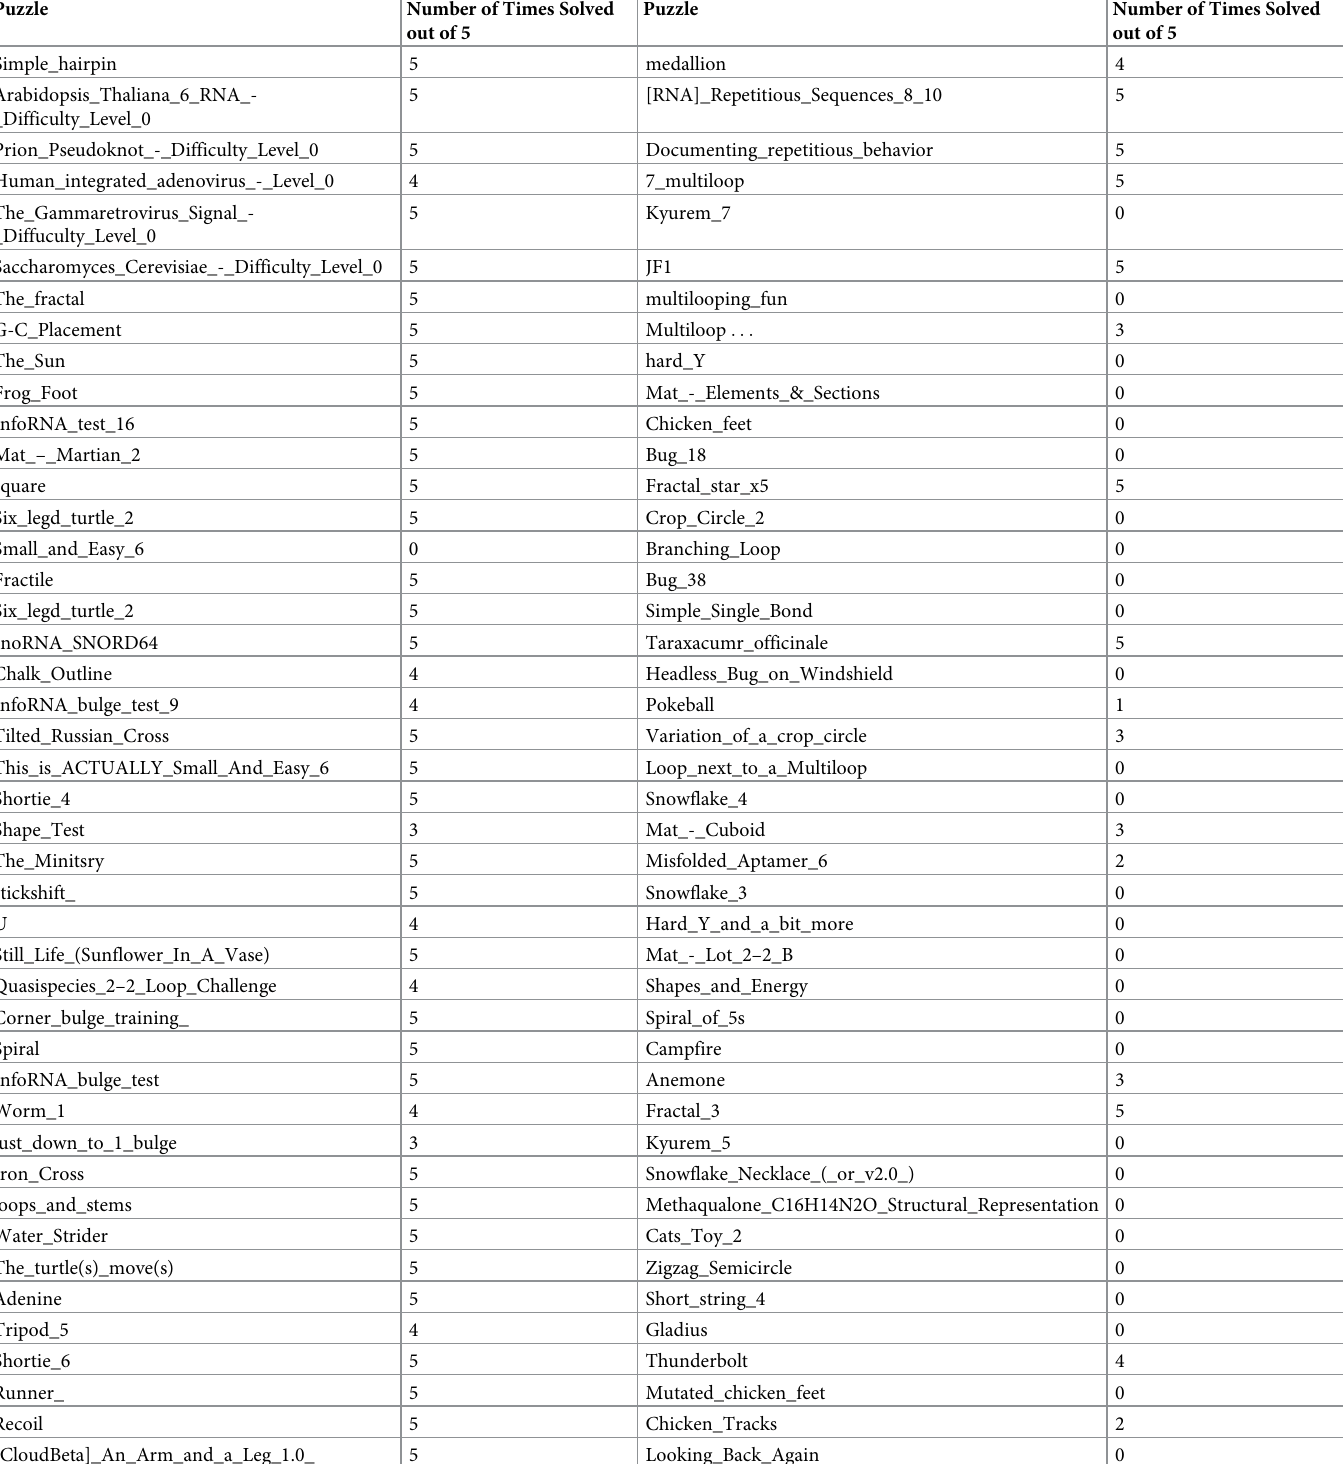
Table 4. EternaBrain-SAP performance on Eterna100 upon five additional playouts on the 61 puzzles it solved in its first run.